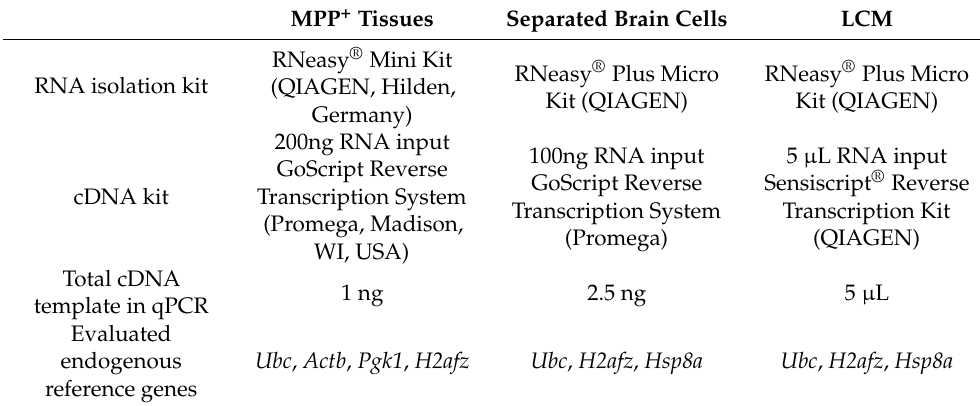
Table 1. RNA isolation, cDNA synthesis, and qPCR.